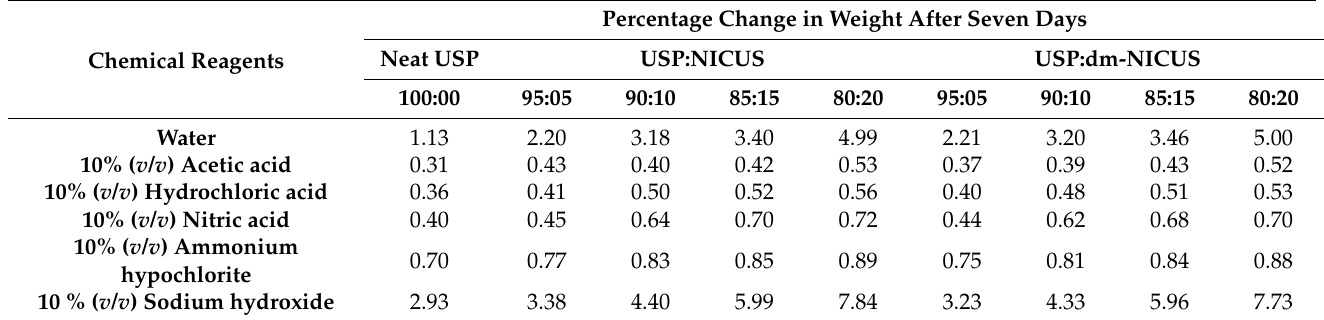
Table 11. Studies on chemical resistance of unsaturated polyester thermoset